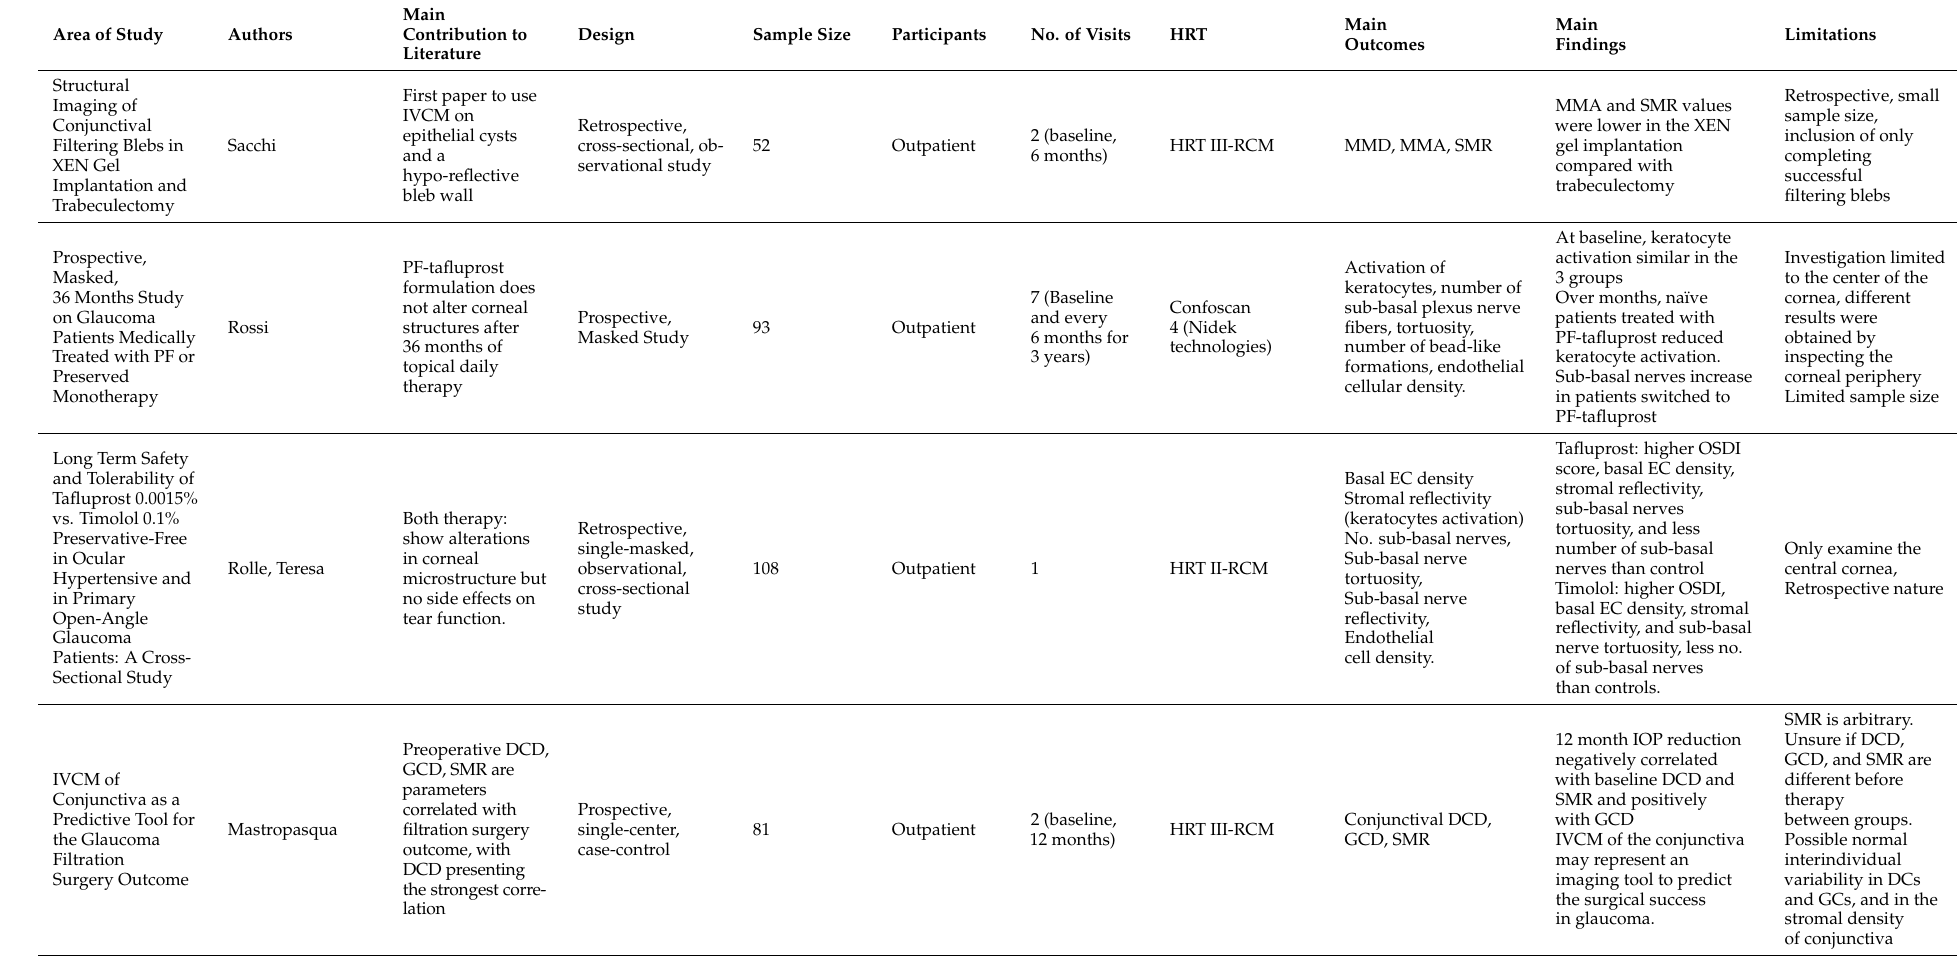
Table 5. Studies on Glaucoma-Related Dry